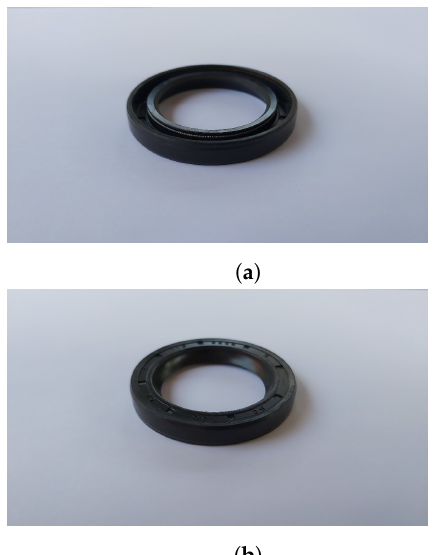
Figure 14. The two side of oil seals. ( a ) Oil seal side that has to face the inside of the product. ( b ) Oil seal side that has to face its crankcase housing.